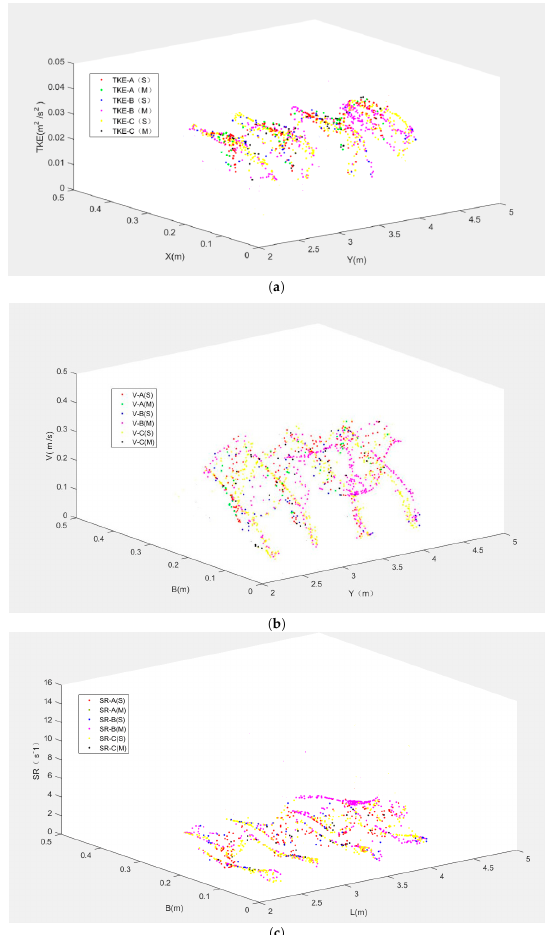
Figure 9 . The differences between simulated (S) and measured (M) trajectories for Fish A, B and C: ( a ) TKE; ( b ) V; ( c ) SR.